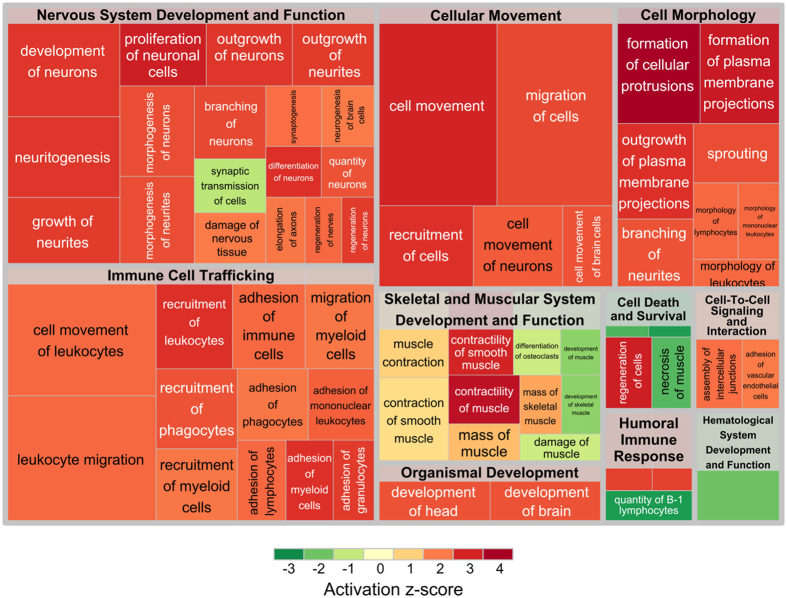
Treemap representing diseases and functions, as calculated by IPA, grouped in macro-processes.Colors indicate the activation z-score of processes: activated processes are colored in red, while inhibited processes are colored in green. Sizes of squares are proportional to −log(p-values). Thus, the greater the size of a square, the more significant its enrichment.